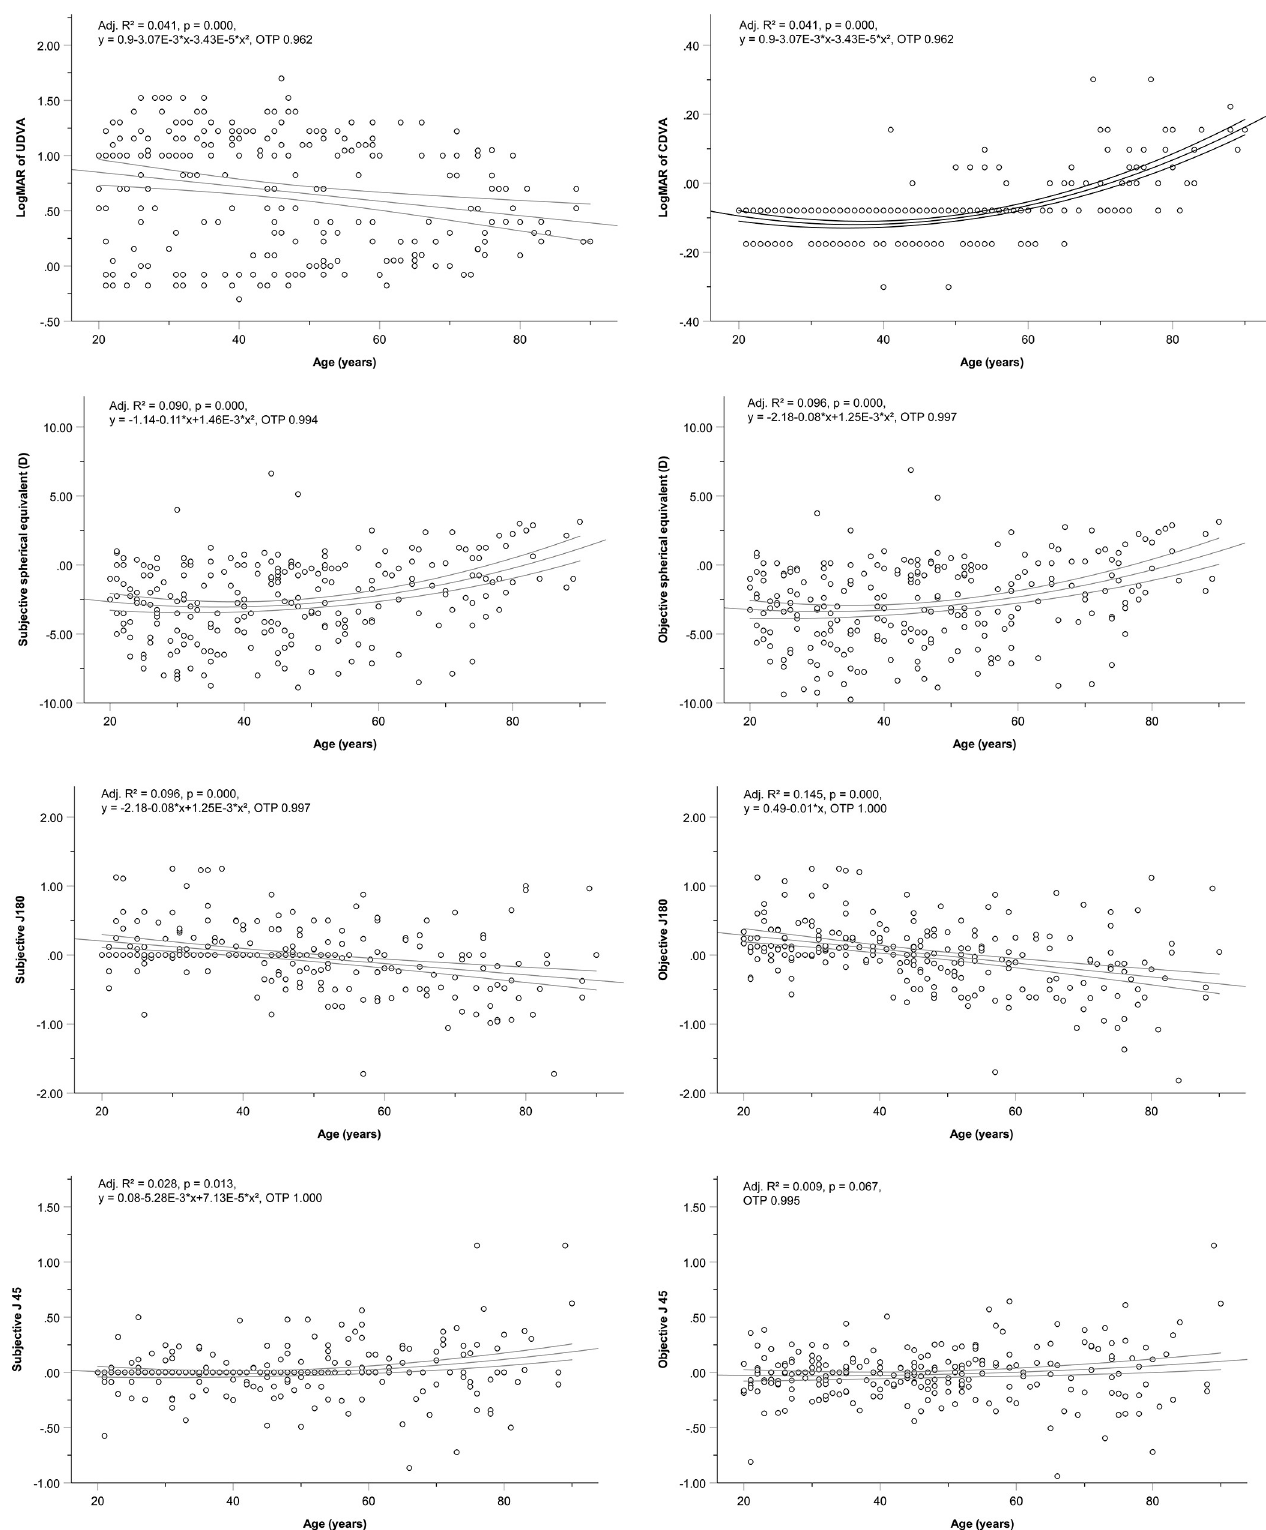
Fig 1. Age-Associated changes in visual acuity and refraction for each study parameter (only significant correlations from Table 3 are shown). (a) Log minimum angle of resolution (logMAR) of the uncorrected distance visual acuity (UDVA); (b) logMAR of the corrected distance visual acuity (CDVA); (c)